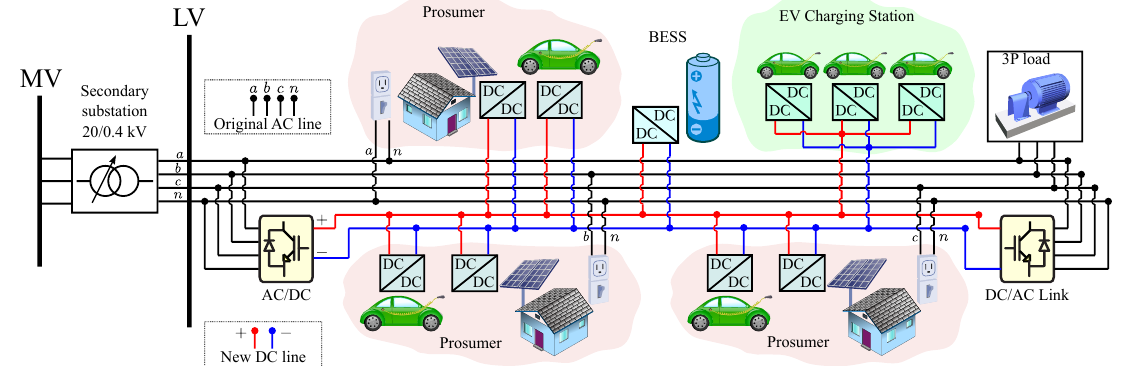
Figure 6. Hybrid AC/DC LV distribution network by adding new DC conductors.